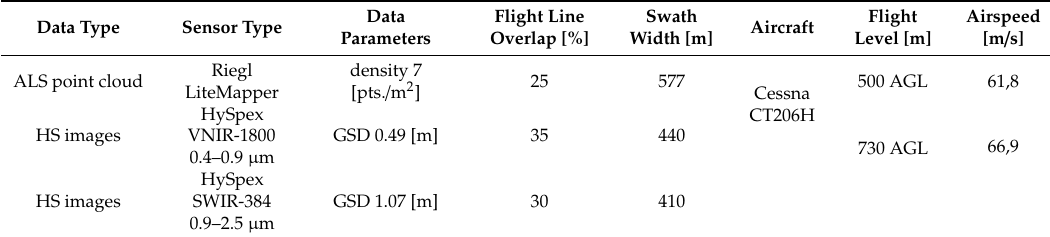
Table 7. Theoretical MFDF flight parameters equal to the parameters of IF data.